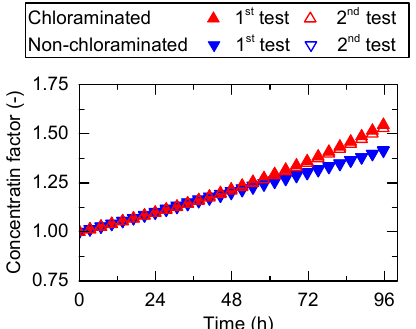
Figure 4. Concentration factor during the pre-concentration of primary wastewater effluent using a FO membrane.